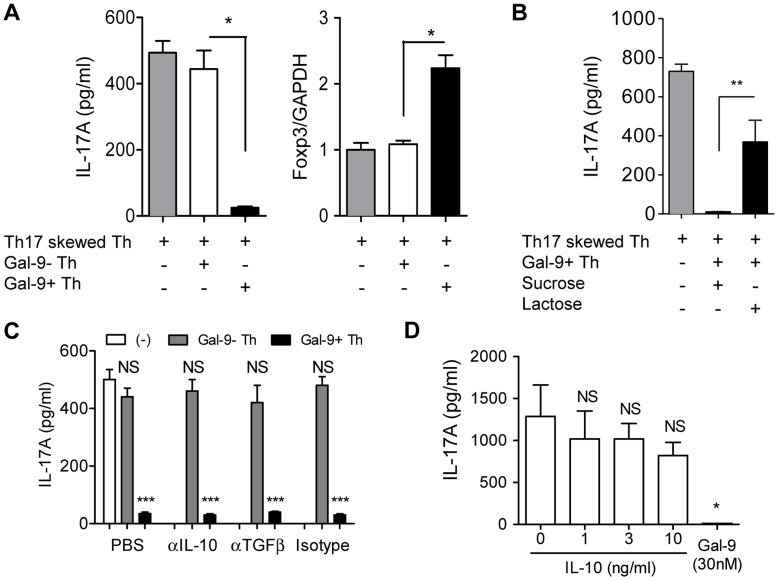
Regulatory function of Gal-9+ Th cells on Th17/Treg development.(A–C) Gal-9+ Th and Gal-9− Th cells were obtained using a cell sorter from naïve CD4 T cells cultured under neutral conditions for 4 days. These cells were co-cultured with Th17-skewed cells at 1∶1 ratio and cultured for 90 h before analysis. (A) IL-17A and Foxp3 expression measured using ELISA and real-time RT-PCR, respectively. (B) IL-17A production in the Gal-9+ Th cell co-culture was examined in the presence of Gal-9 antagonist lactose or irrelevant sugar sucrose. (C) IL-17A production was examined in the presence of anti-IL-10 or anti-TGF-β blocking antibodies. (D) Naïve CD4 T cells were cultured under Th17-skewing conditions for 4 days in the presence of indicated concentration of IL-10 or human stable Gal-9 before IL-17A was measured. Results are shown as the mean ± SEM of quadruplicate experiments. p<0.001 (***), p<0.01 (**), p<0.05 (*), not significant (NS). Representative data out of at least 2 experiments are shown.